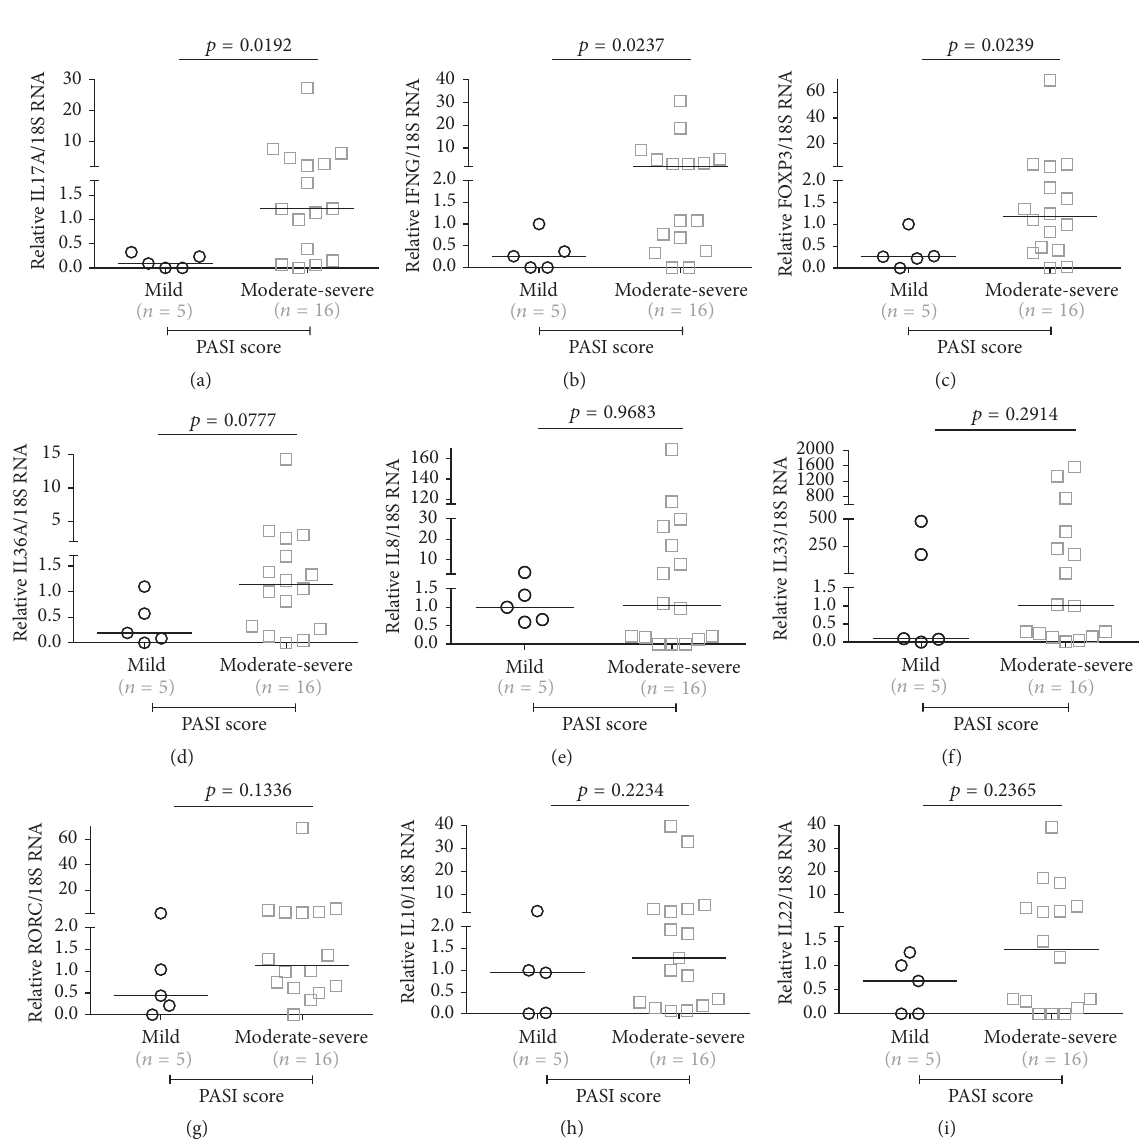
Figure 1: Transcripts levels of (a) IL17A, (b) IFNG, (c) FOXP3, (d) IL36A, (e) IL8, (f) IL33, (g) RORC, (h) IL10, and (i) IL22 according to PASI’s severity disease.